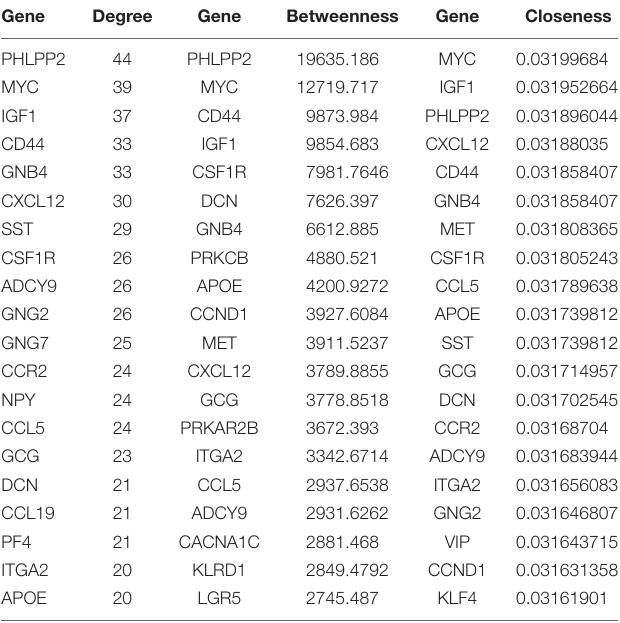
TABLE 2 | Top 20 nodes of DEGs in PPI network conducted based on 514 DEGs between CRA tissues and normal tissues. Gene